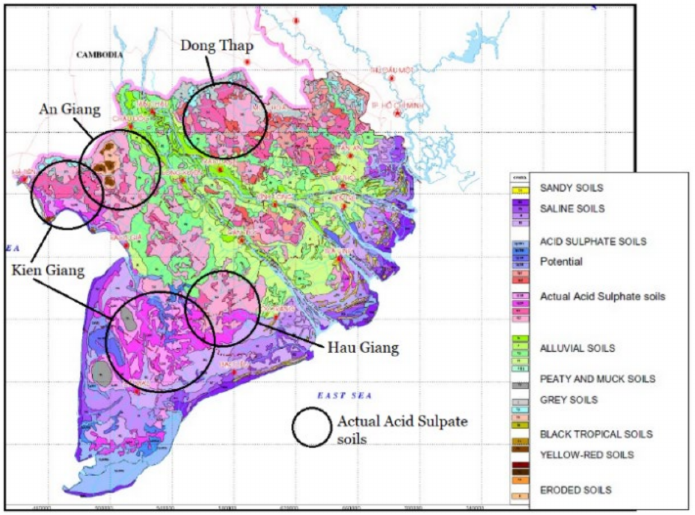
Figure 8. Soil map of Mekong Delta, Vietnam. Source: Southern Institute for Water Resources Planning (SIWRP)